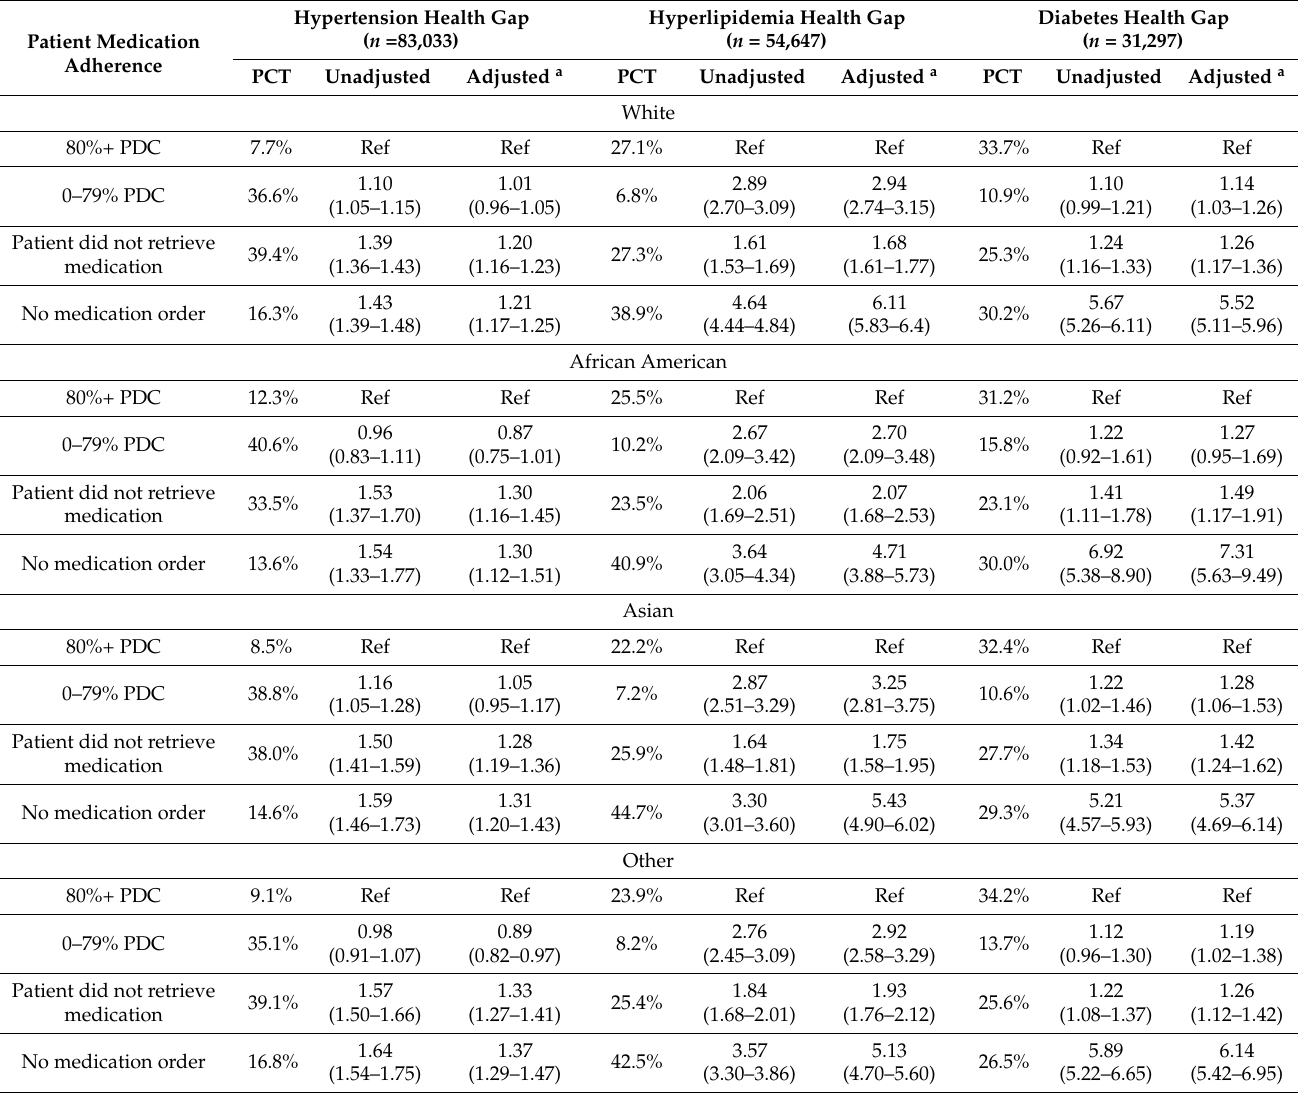
Table A1. Logistic Regression model-based estimates of the odds ratio for the relationship between medication adherence, as defined by proportion of days covered (PDC) and patient health gap status with and without adjustment for other covariates, stratified by race